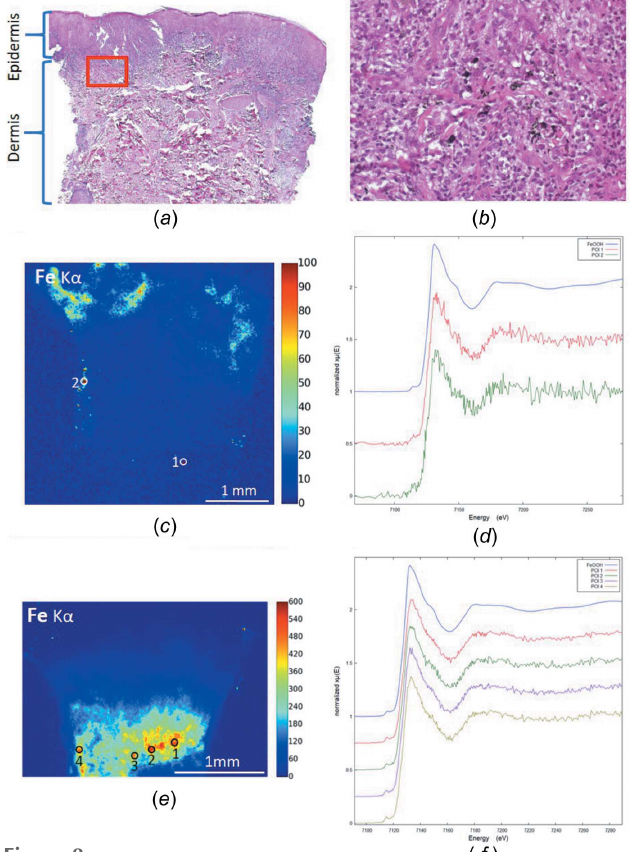
Figure 8 XRF maps with localized POI and XANES spectra at the Fe K -edge (patients 10 and 11). A reference spectrum of an iron oxyhydroxide compound (FeOOH) is also shown as comparison. ( a ) Patient 10, optical microscopy HES (cid:4) 40. ( b ) Patient 10, optical microscopy, HES (cid:4) 400 [corresponding to the red rectangle on panel ( a )], with clear identification of dark ink. ( c ) Patient 10, Fe XRF map. ( d ) Patient 10, XANES spectra at the Fe K -edge. ( e ) Patient 11, Fe XRF map. ( f ) Patient 11, XANES spectra at the Fe K -edge.